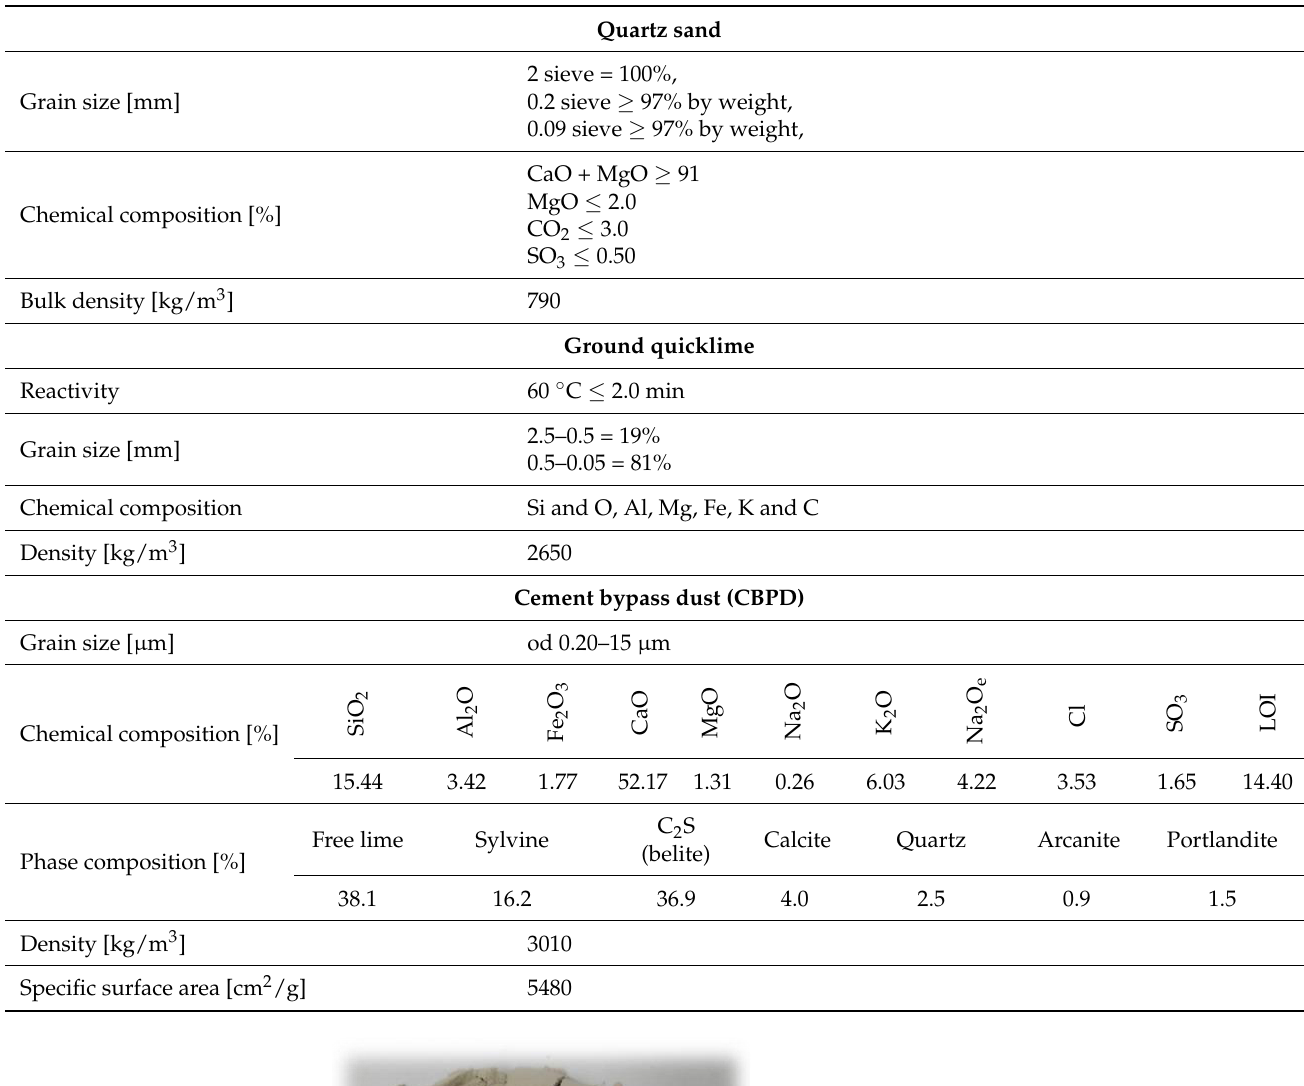
Table 1. Physical and chemical properties of the materials used. Quartz sand